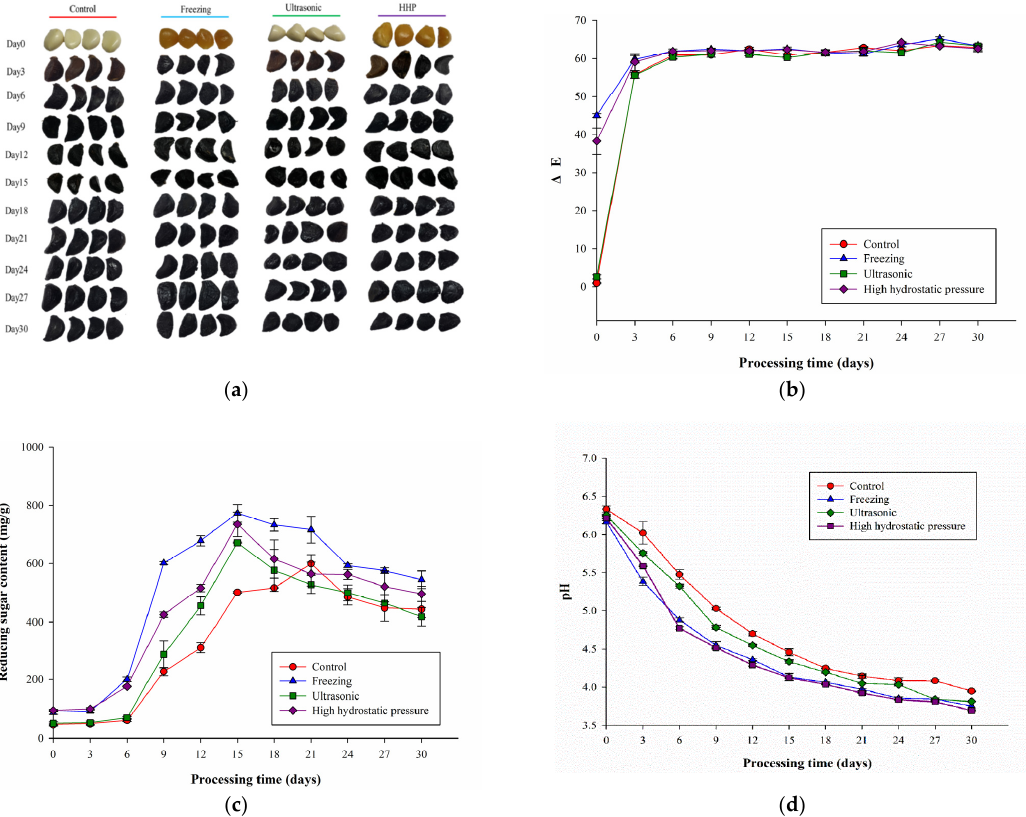
Figure 1. ( a ) Appearance, ( b ) Δ E, ( c ) reducing sugar content (mg/g dry weight), and ( d ) pH of garlic subjected to different pretreatment methods during thermal processing (70 °C, 80% RH for 30 days). All values are means ± standard deviations ( n = 3). Control: only heat treatment at 40 °C, 80% RH for 6 days. Freezing: frozen at − 20 °C for 30 h and then heat-treated at 40 °C with 80% RH for 6 d. Ultrasonic: 28 kHz for 2 h and then heat-treated at 40 °C with 80% RH for 6 d. High hydrostatic pressure: 300 MPa for 15 min and then heat-treated at 40 °C with 80% RH for 9 d. As the processing time of BG increases, the pH value gradually decreases, and the increase in organic acid contents makes the taste of BG slightly sour [5,17]. The results of pH changes are shown in Figure 1d. During the heat treatment, the pH value of garlic gradually decreased. In addition to the release of organic acids due to the destruction of the garlic cell structure, organic acids were also generated during the heat treatment pro- cess, resulting in a decrease in the pH value of BG [5]. Liang et al. [18] noted that during the heating of garlic, the contents of acetic acid and formic acid increased significantly, mainly as a result of the cleavage of α -dicarbonyl and β -dicarbonyl of five-carbon or six- carbon sugars. During heat treatment at 70 °C, the pH values of the control, freezing, HPP, and ultrasonic pretreatment groups decreased from 6.33 to 3.95, 6.16 to 3.75, 6.21 to 3.69, and 6.25 to 3.81, respectively. Overall, the pH values of the pretreated samples were lower than that of the control group, indicating that the cell structure of these samples was dam- aged more severely, resulting in the release of more organic acids and lower pH values. Similarly, the results of Choi et al. [19] showed that the pH value of garlic after heat treat- ment at 70 °C for 28 days decreased from 6.33 to 4.07, similar to the trend of the control group in this experiment.